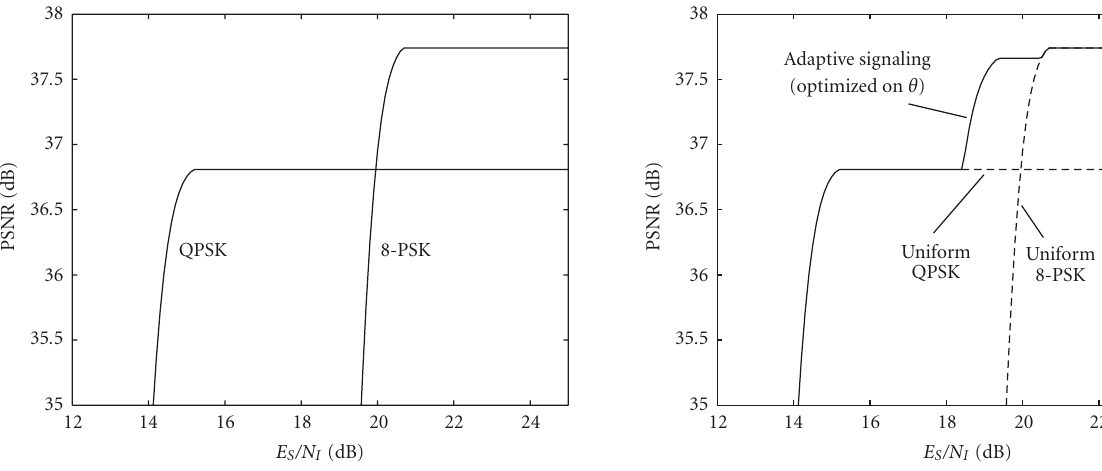
Figure 8: PSNR as a function of E S /N I in dB for 2-layer system with adaptive modulation scheme without channel coding for AWGN channel. Fixed symbol transmission rate r S =